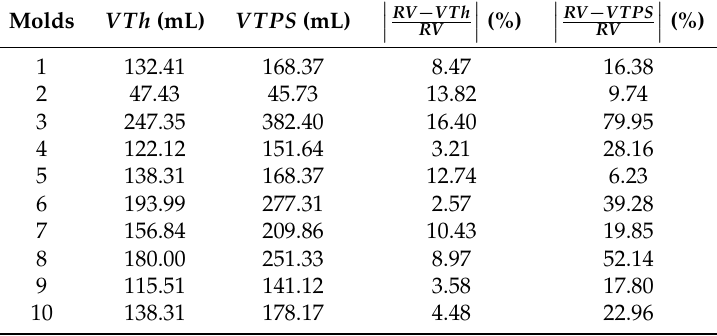
Table 2. Results obtained for the LVV through the Teichholz and TPS models, and the respective errors when compared to the